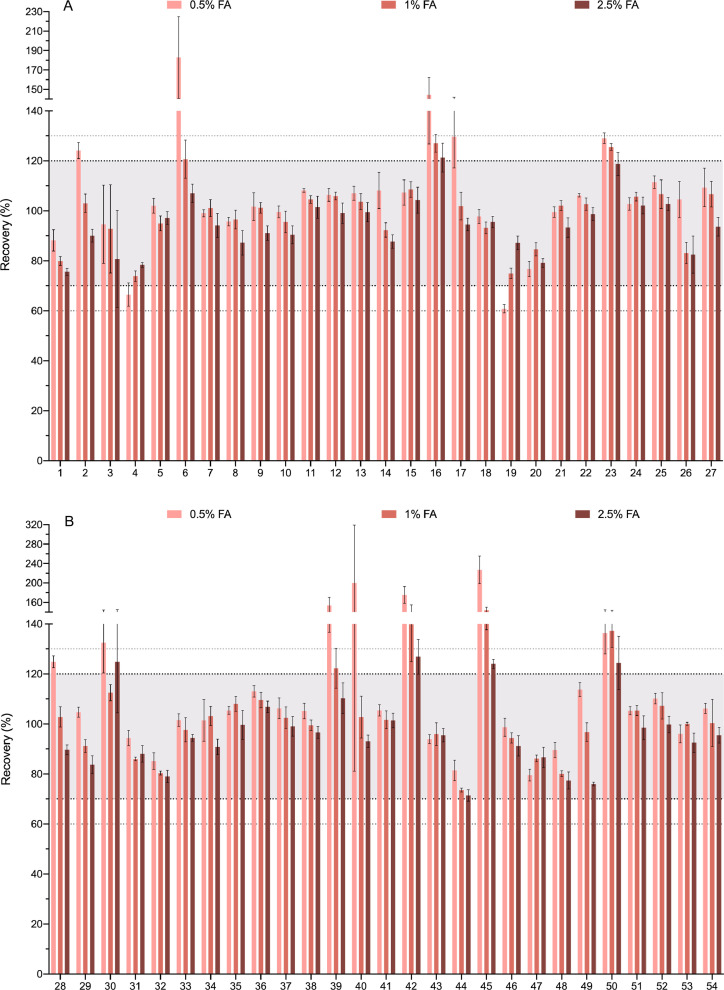
Optimization of the amount of formic acid. Three concentrations of F.A. (0.5%, 1%, 2.5%) are shown for each compound. The compounds are numbered according to the relation in Table 1. Bold-dotted lines shows the recovery limits recommended by the SANTE guide as acceptable (70% and 120%). Since the same guide also permits an expanded 60–130% when the results are highly reproducible these limits are also marked with dotted lines. For clarity the graph has been divided in 8 panels.